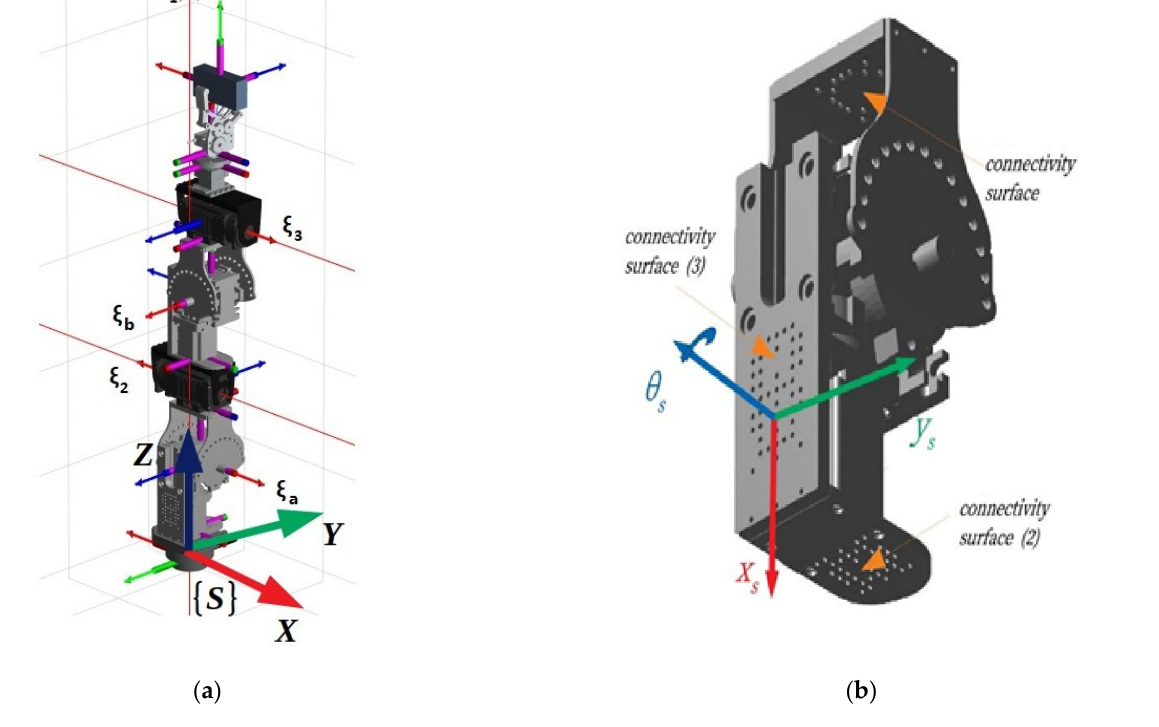
Figure 1. A CAD view of the SMM: ( a ) The structure under study; ( b ) the pseudo joint module and its respective connectivity surfaces.